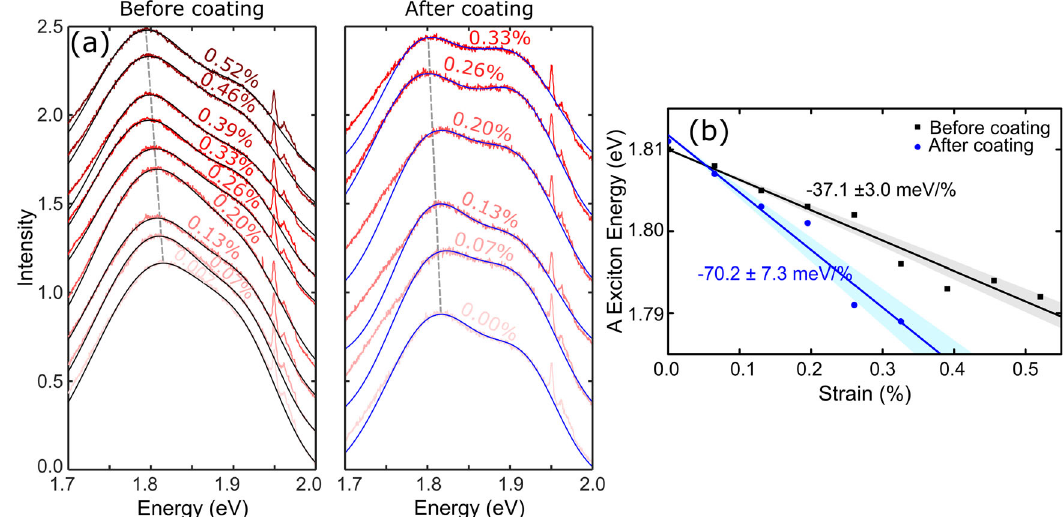
Fig. 6 Strain tunable photoluminescence. a Photoluminescence spectra acquired for different uniaxial strains on a single-layer MoS 2 fl ake before and after adamantane plasma polymer encapsulation. b A exciton energy as a function of uniaxial strain before and after encapsulation. The data has been fi t to a straight line to extract the gauge factor value (solid line). The shaded area around the solid line indicates the uncertainty of the fi